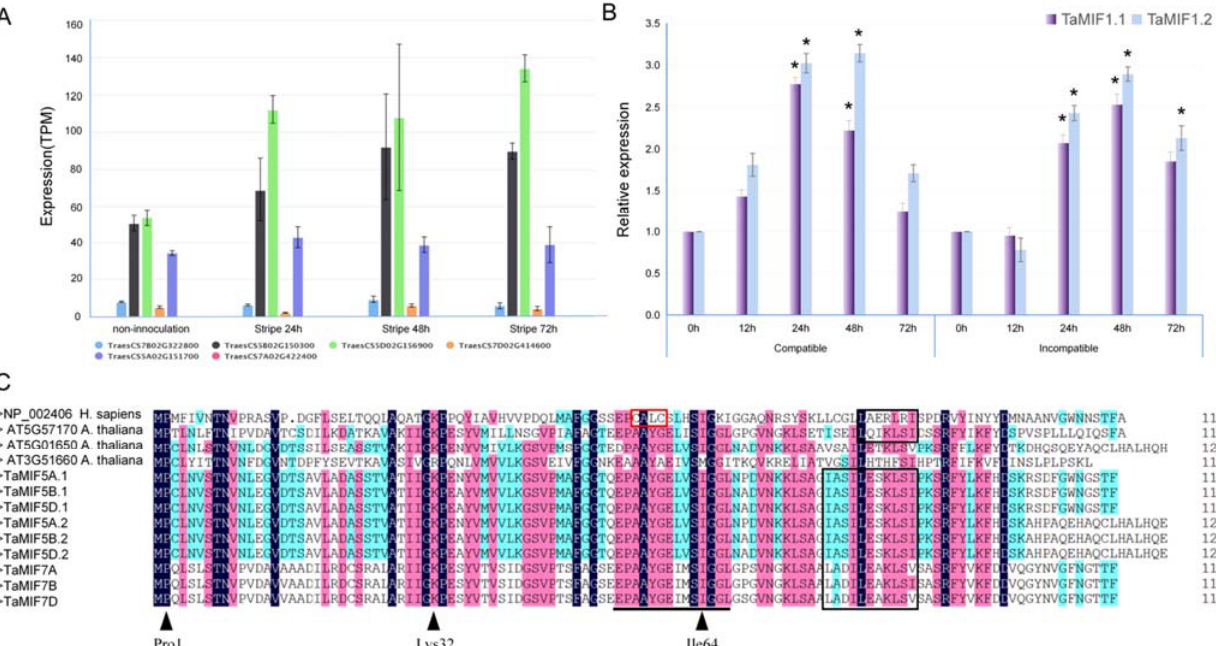
Figure 1. Sequences analysis of Ta MIFs. ( A ) Developmental expression profile of Ta MIFs. Expression analysis of TaMIF genes in different Pst infection periods; column height shows expression of TaMIF genes on the basis of log-transformed TPM (transcripts per million) value. ( B ) Transcript profiles of two transcripts on wheat chromosome 5B. Relative transcript levels were analyzed in both compatible and incompatible wheat– Pst interactions from 0 hpi to 72 hpi. Relative transcript levels of TaMIFs were calculated by the comparative 2 − ∆∆ Ct method with TaEF1 as internal standard and relative to that of 0 hpi. Bars indicate means of three independent biological replicates ( ± SE). Asterisks indicate significant differences ( p < 0.05) relative to the 0 hpi sample. ( C ) Multi-sequence alignment of Hs MIF, At MIFs, and Ta MIFs. Amino acid sequences of Hs MIF, At MIFs, and Ta MIFs were aligned with DNAMAN 6.0 using standard parameters. Identical amino acids are shown in black; black triangles are tautomerase active site residues that exist in MIFs; red box represents the C-X-X-C motif in Hs MIF. The black line indicates the location of InterProScan domain IPRO19829 (MIF, conserved site) in MIFs; black boxes indicate the predicted NES.